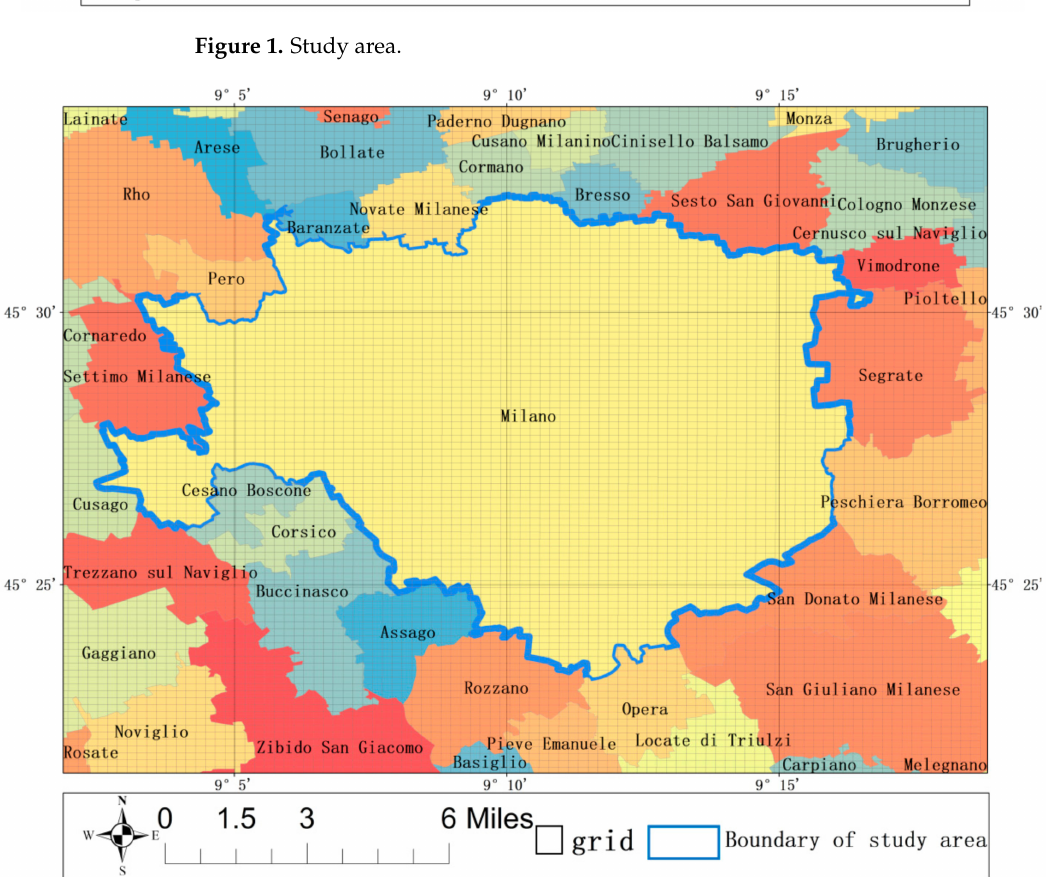
Figure 2. The map overlay of the study area with the 10,000